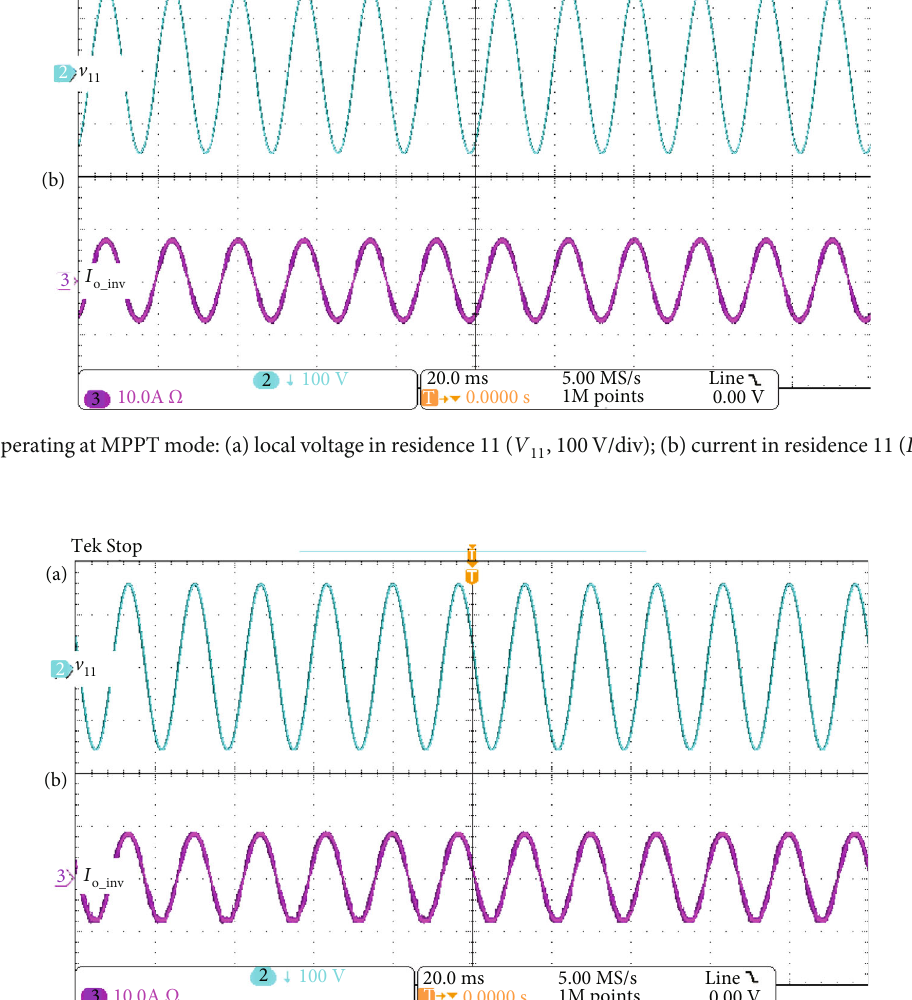
Figure 8: System operating at APC mode: (a) local voltage in residence 11 ( V